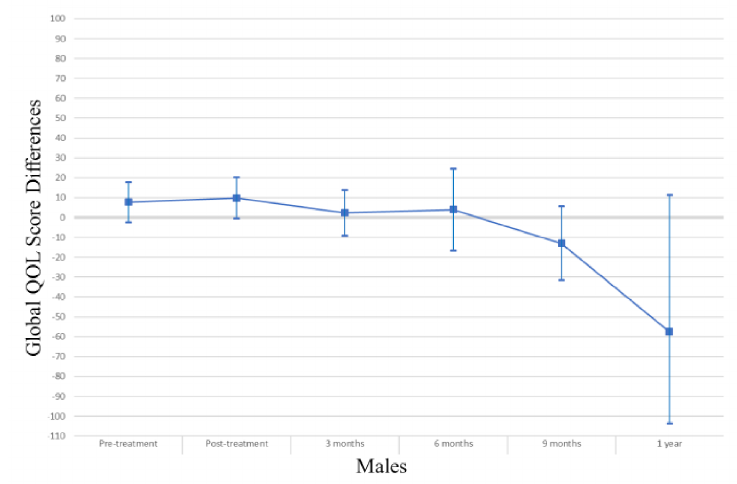
Figure 2. Global QOL score differences in male study population.